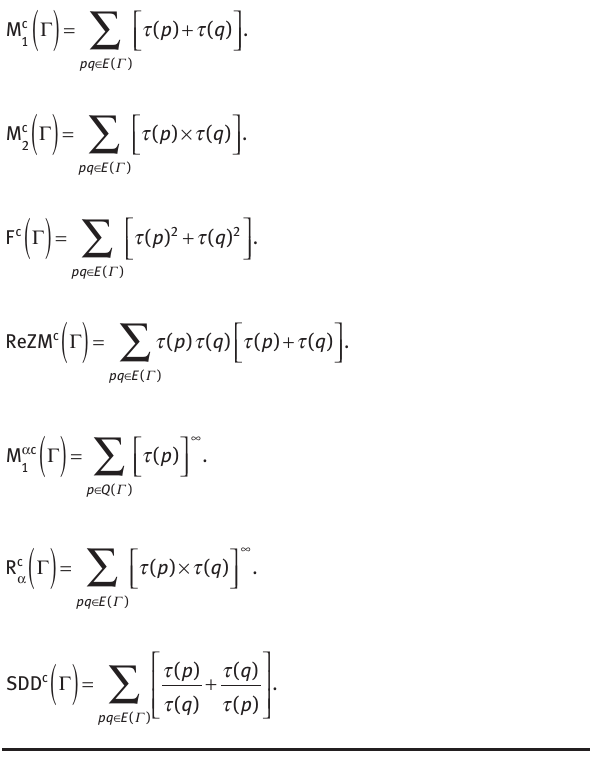
Table 1: Zagreb indices.